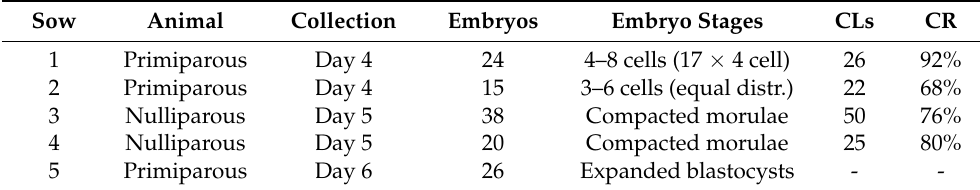
Table 1. Number of in vivo embryos and their developmental stages collected from five sows on different days of the oestrus cycle. Collection rate (CR) was calculated by dividing the total number of embryos collected by the number of corpora lutea (CLs) counted on both ovaries. Embryos from sow 5 were collected from one horn only and the number of CLs was not